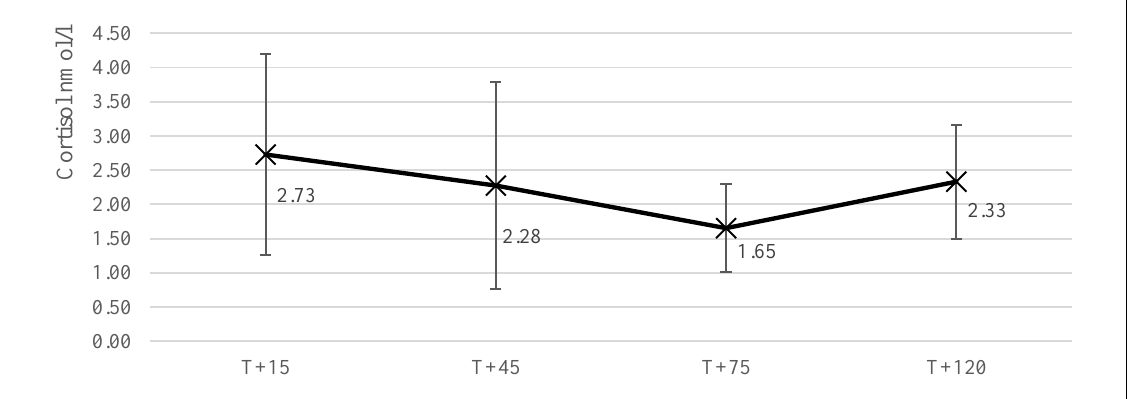
Figure 2. The various mean levels of salivary cortisol (±SD) at the four different sample points for the collective training session ( n = 13 at T + 15, n = 16 at T + 45, n = 16 at T + 75, and n = 14 at T + 120). The training session took place between T + 45 and T + 75.